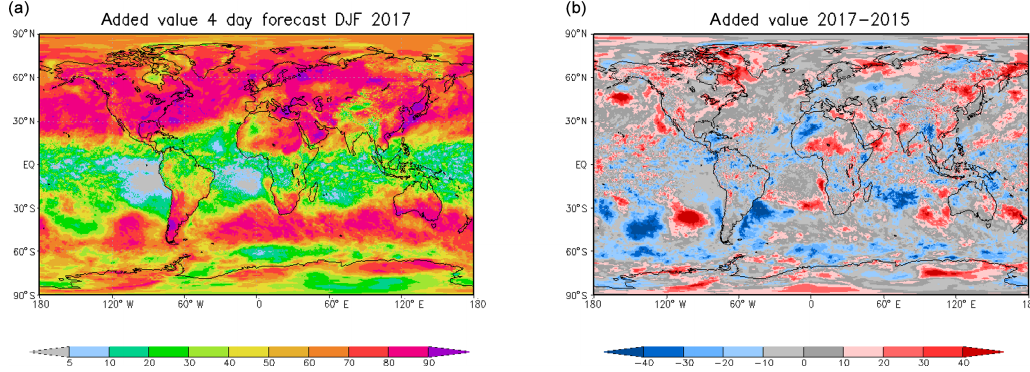
Figure 6. As in Fig. 4 but for added values of ECMWF lead day 4 dynamic forecasts of 2m temperature with respect to damped lag day − 4 persistence forecasts for the winter of 2016–2017 (a) . Differences in the added values between the winters of 2016–2017 and 2014–2015 (b) .